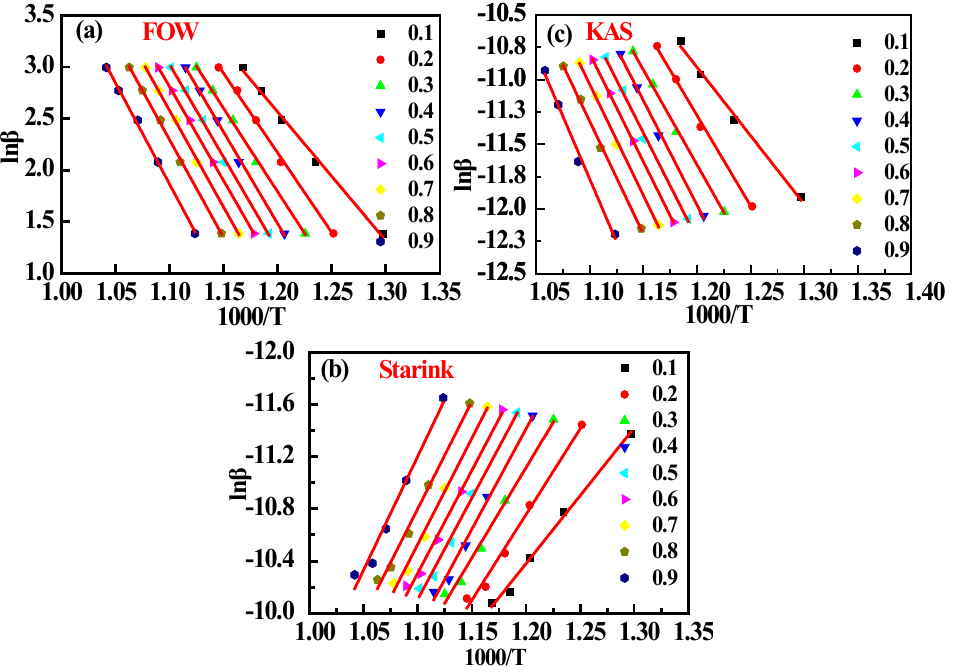
Figure 2. Plots of the isoconversional methods for the carbon conversion ratios X in the range of 0.1–0.9: ( a ) FWO method (Equation (2)); ( b ) KAS method (Equation (3)); ( c ) Starink method (Equation (4)). Table 3. Activation energies E a (KJ·mol −1 ) of the steam gasification reaction of the char obtained at different values of X using the FWO, KAS, and Starink methods. The average value of E a ( E ave ) obtained for 0.2 ≤ X ≤ 0.8 is also presented.